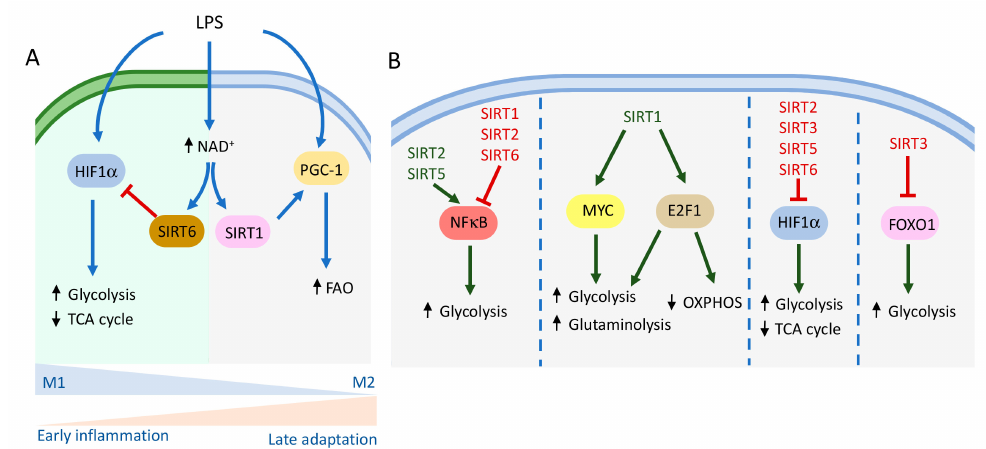
Figure 1. Metabolic control of macrophage fate by sirtuins. ( A ) Proinflammatory conditions lead to an increase in NAD + and SIRT1 and SIRT6 activation, which drive a metabolic reprogramming from glycolysis to fatty acid oxidation during the resolution of the inflammation. ( B ) Sirtuins control macrophage metabolism by regulating the activity of several transcription factors. Blue/green arrows indicate positive regulation, red arrows indicate negative regulation. Up and down black arrows indicate upregulation and downregulation of indicated metabolic pathways,